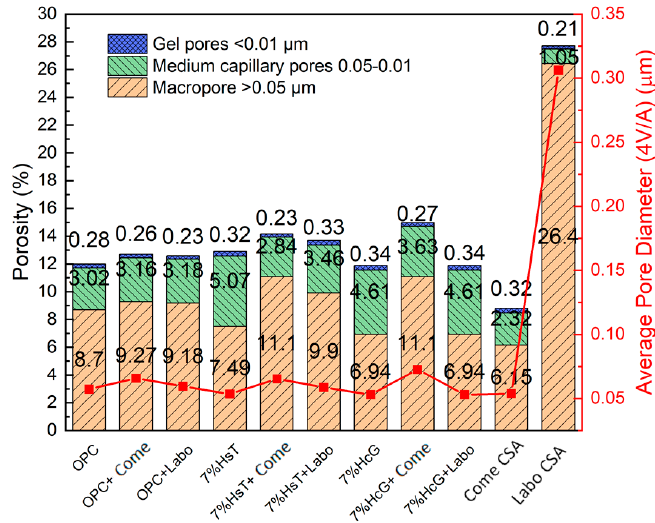
Figure 7. Porosity and average pore diameter at 28 days of curing.